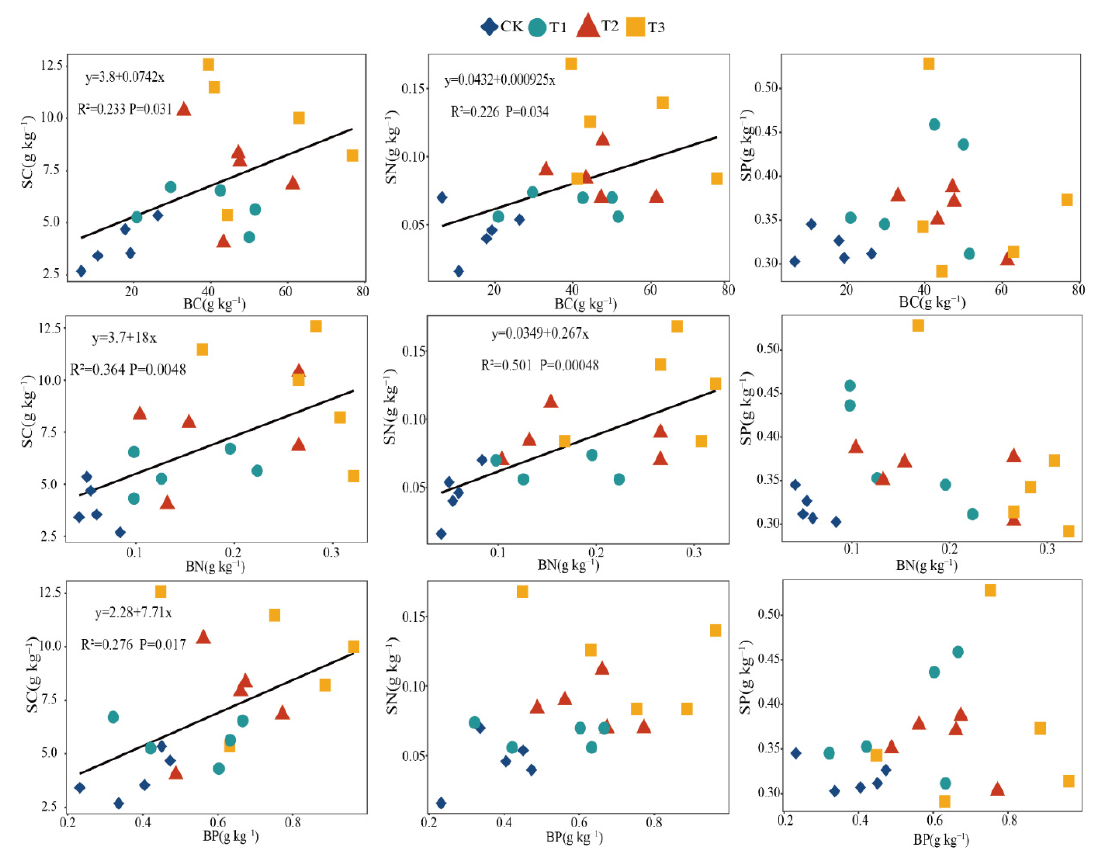
Figure 3. Linear regression indicating relationships between OC (C), TN (N), and TP (P) in the soil and C, N, and P in the moss crusts under different biochar treatments. The solid blank line indicates a significant correlation ( p < 0.05). Notes: BC = moss crust C, BN = moss crust N, BP = moss crust P, SC = soil C, SN = soil N, SP = soil P.